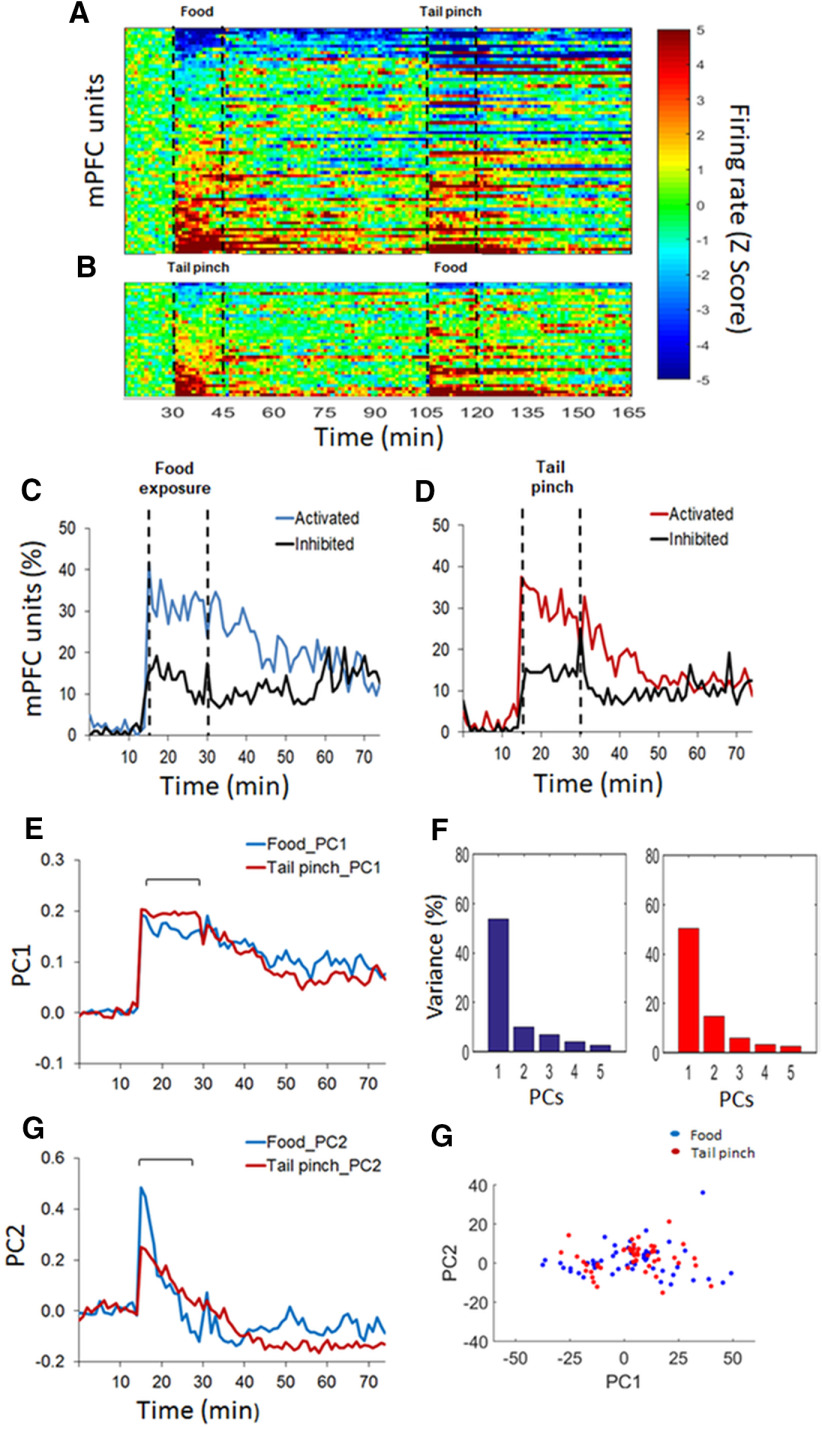
dmPFC population activity during rewarding and stressful events. A, B, Heat plots represent the baseline normalized firing rate for single units. Each row is the activity of a single unit in 60-s time bins aligned to the first event, sucrose food exposure (A) or tail pinch (B; 15 min, dashed lines); and sorted from lowest to highest average normalize firing rate. C, D, Time course of single unit’s activation and inhibition during sucrose food exposure (C) and tail pinch (D). All units represented in A, B are included. The percentage of units was categorized as activated or inhibited based on whether their averaged activity by 60-s time bins was significantly different from baseline activity. E–G, Temporal profile of the population activity associated with the top two principal components (PC1 and PC2) for sucrose food exposure and tail pinch. F, Variance explained by the top five principal components for both events. H, Representation of single units in the 2-d space according to the top two principal components.